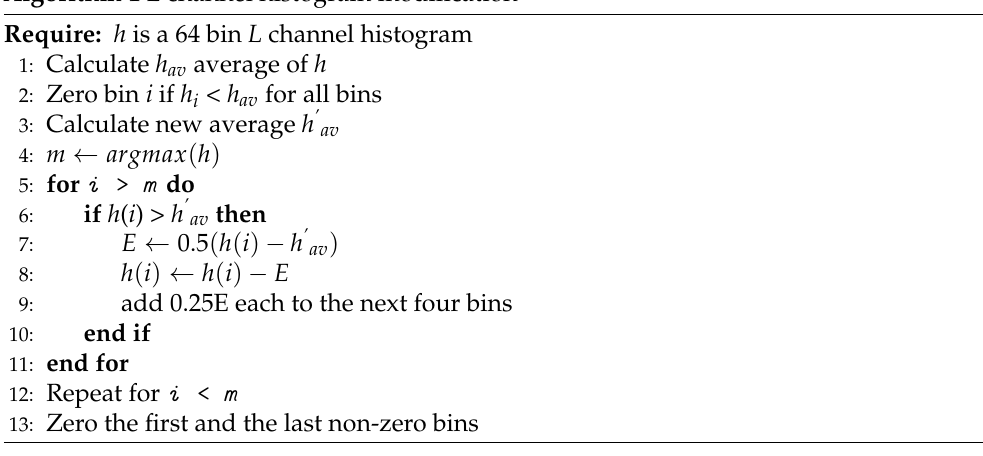
Algorithm 1 L channel histogram modification